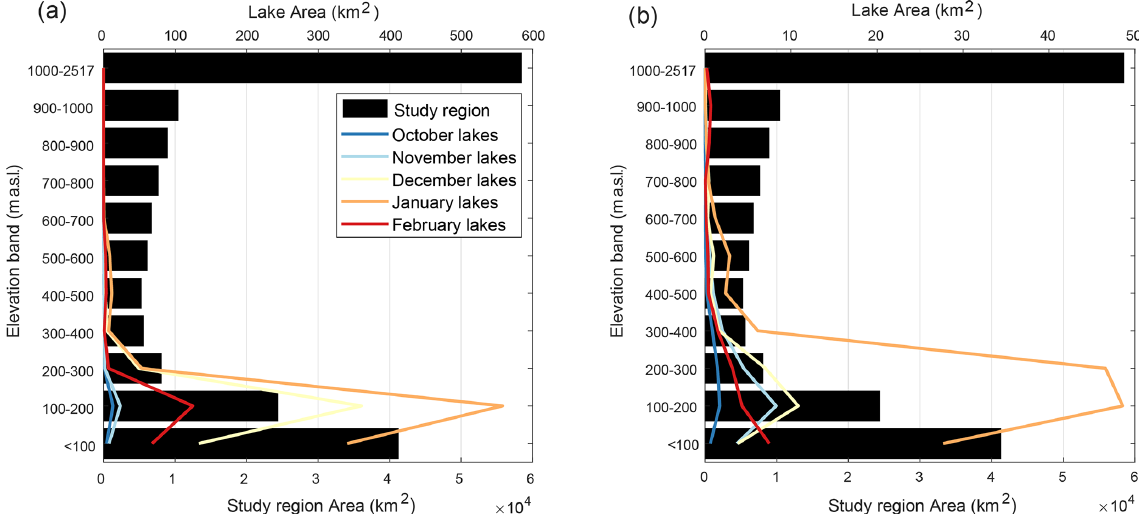
Figure 7. Averaged total lake areas per month by elevation bands, for a high-melt season ( a , 2005/06) and a low-melt season ( b , 2015/16). Black horizontal bars show the hypsometry of the study region. Note the total lake area is an order of magnitude greater during the high-melt year (see lake area scales). Table 2. Descriptive statistics for the time window with the greatest total lake area, for each melt season included in the study. Melt season Time window of highest Largest lake area Standard deviation Elevation of 95th % lake area total lake area (km 2 ) of lake area percentile lake (min grounded four pixels)